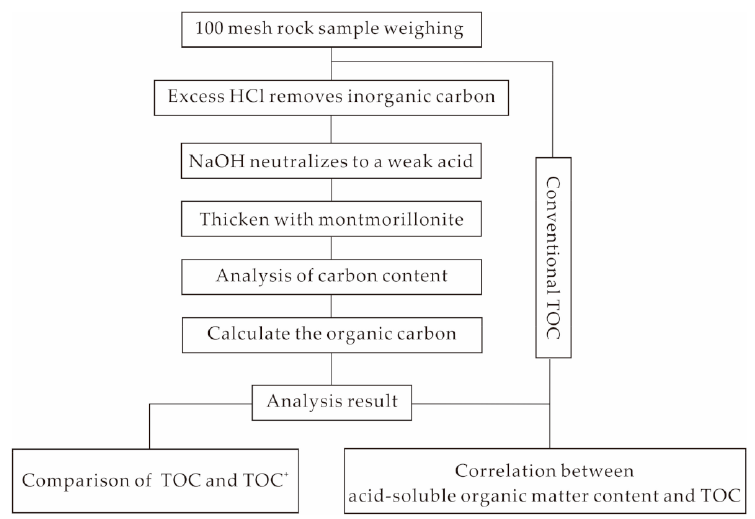
Figure 1. Flow chart of the experimental procedure (modified from Liu Peng